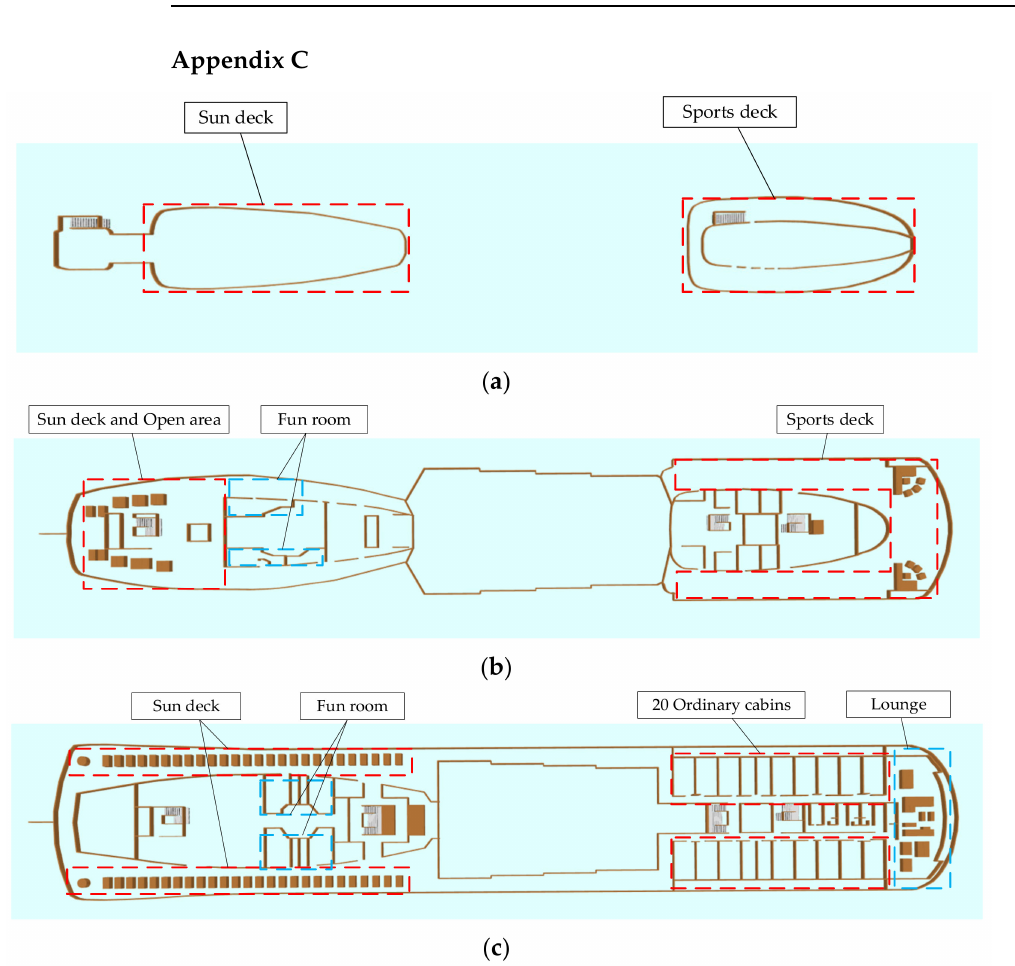
Figure A13. Cont